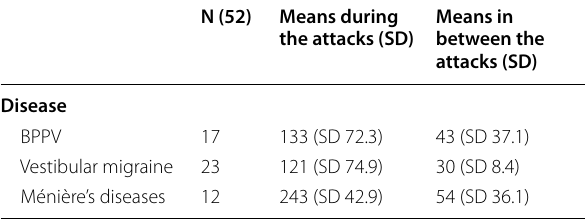
Table 2 Summary of the mean VADL scores among the three episodic vestibular disorders